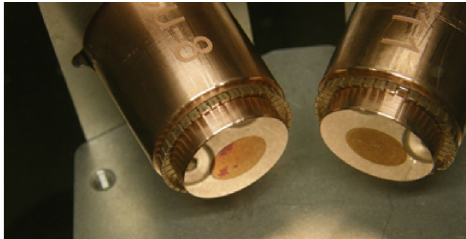
FIG. 1. SwissFEL cathode plugs parked in the carousel holder of the loadlock chamber. A disc of 10 mm diameter of Cs 2 Te has been deposited on the front surface.